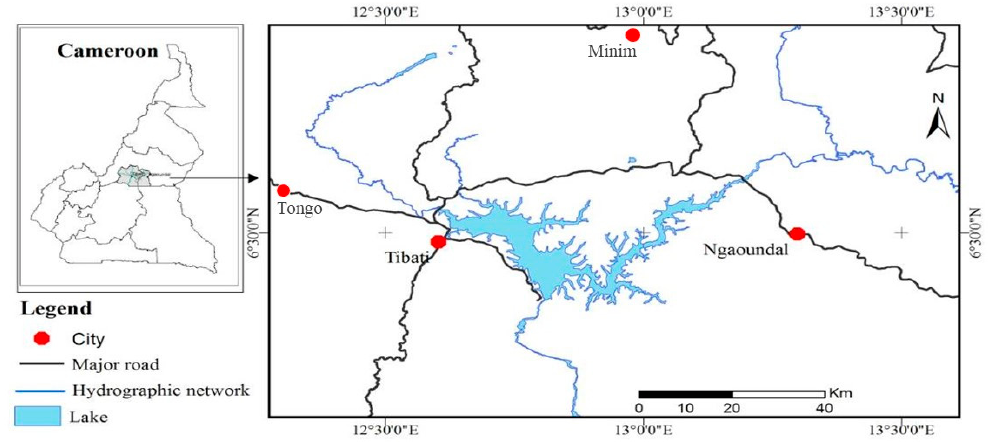
Figure 1. Location map of the bauxite bearing areas of southern